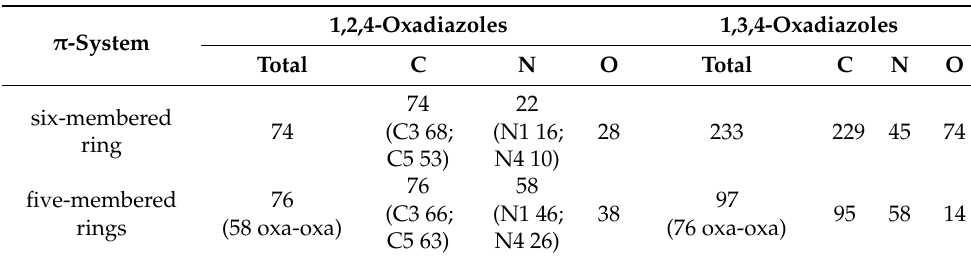
Table 2. The (oxadiazole)··· π interactions found in the CSD and categorized by the type of interacting atom. π -System